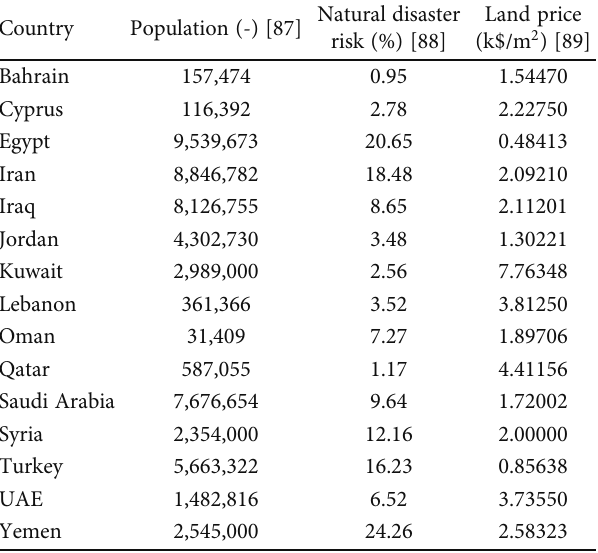
Table 9: The value of under study parameters (unstimulated).